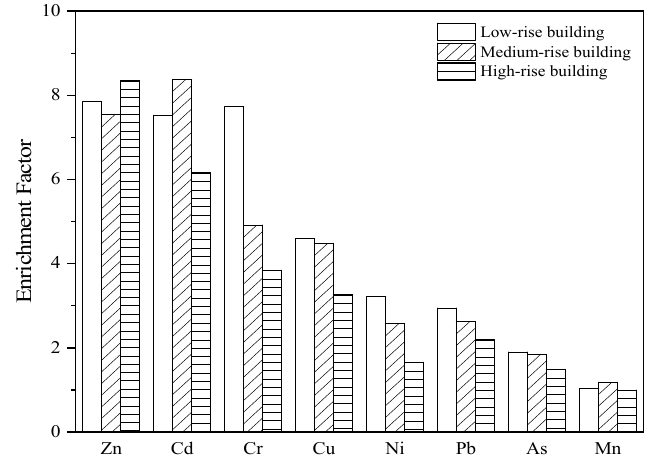
Figure 3. Enrichment factors for heavy metals in the dust fall on buildings differing in height.